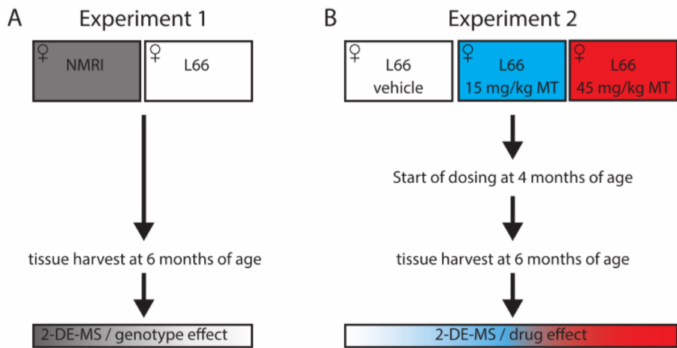
Figure 1. Study design for proteomics analyses. Proteomics analyses were conducted in ( A ) untreated wild-type and L66 mice, to identify proteins changing due to tau over-expression (experiment 1), and ( B ) in vehicle- or LMTM-treated L66 mice, to identify the effect of LMTM (experiment